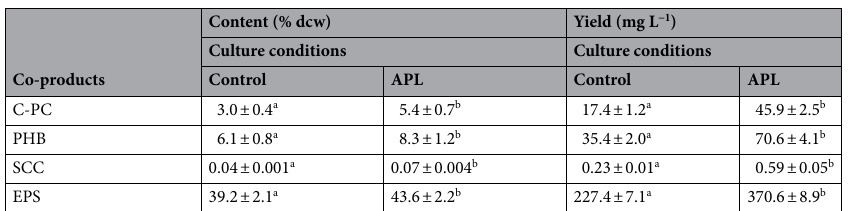
also predominated by higher yields of fermentable components such as reducing sugar and glycogen (Supple- mentary Figure S1). Consequently, an elevated volumetric production of bioethanol was obtained using the APL medium. Compared to 118.4 mg L −1 in BG-11 control, the bioethanol yield obtained from APL-grown A. variabilis showed a rise to 219.9 mg L −1 , signifying a 46.2% higher value. Nevertheless, for both the conditions (control and APL), the bioethanol conversion % was found to range between 44 and 44.3% (Table 7). APL medium also served effectively for significant accumulation of all the co-products (Table 8). Using this medium, C-PC content was increased to 5.4% dcw from 3.0% dcw in BG-11 control. On the other hand, PHB and SCC contents were respectively enhanced to 8.3% and 0.07% dcw in the APL medium compared to 6.1% and 0.04% dcw in control. A marginal increase was also witnessed in the EPS content from 39.2% (control) to 43.6% dcw (APL medium). This upsurge in the cellular concentration of the co-products alongside the augmented biomass yield of A. variabilis in the APL medium also heightened their volumetric production. A ~ 61–62% increase was noted for SCC and C-PC yield, recording respective values of 0.59 mg L −1 and 45.9 mg L −1 in the APL medium compared to 0.23 mg L −1 and 17.4 mg L −1 in BG-11 control. Likewise, the yield of PHB and EPS were also elevated to 70.6 mg L −1 and 370.6 mg L −1 from 35.4 mg L −1 and 227.4 mg L −1 in control, indicating a respective ~ 50% and ~ 39% rise (Table 8). Bioethanol and the co-products harnessed from A. variabilis and their validation using different confirma- tory analyses have been summarized in Fig. 4, the comprehensive illustration of which has been provided in Supplementary Figures S2–S7. Bioethanol was obtained after fermentation of the pretreated hydrolysate and harvested by phase separation (Fig. 4a) using Tri-n-butyl phosphate (TBP). The bioethanol production was confirmed using GC–MS analysis, where its presence was detected at the retention time of 1.68 min (Fig. 4a and Supplementary Figure S2), refer- ring to the NIST mass spectral library. C-phycocyanin (C-PC) was extracted as water-soluble blue color pigment and stored as freeze-dried powder (Fig. 4b). The confirmatory detection of C-PC was based on the spectrophotometric determination of the distinct peak at 620 nm, the absorption maxima of C-PC (Fig. 4b and Supplementary Figure S3). Poly-β-hydroxybutyrate (PHB) was extracted as white polymer, and its accumulation in A. variabilis was detected using GC analysis (Fig. 4c). The polymer sample obtained from the test cyanobacterium conformed to the standard PHB exhibiting the specific peak at the retention time of 4.5 min, hence, confirming PHB synthesis by A. variabilis (Supplementary Figure S4). Chlorophyll extracted from A. variabilis was converted into its water-soluble derivative- sodium copper chlorophyllin (SCC), which appeared as blue-black powder (Fig. 4d). The identification of SCC was performed using two confirmatory tests (copper test and flame test) to validate the presence of copper in it. In copper test, the formation of a brown-colored complex of copper diethyldithiocarbamate after addition of sodium diethyl- dithiocarbamate confirmed the presence of copper in the produced SCC sample. In flame test, the SSC sample solution burnt with a green-colored flame, hence, reconfirming the presence of copper in it (Fig. 4d). Addition- ally, the absorption spectrum of the produced SCC sample was also found to be similar to the standard SCC, showing peaks at the wavelengths of 405 nm and 635 nm (Supplementary Figure S5). This analogy in absorbance behavior again validated the SCC formation in the present study. Exopolysaccharides (EPS) extracted from the test cyanobacterium when freeze-dried appeared as white cottony fiber (Fig. 4e). HPLC analysis revealed the obtained EPS to be constituted of pentoses like ribose and xylose; and hexoses, such as mannose, glucose, and galactose (Supplementary Figure S6), demonstrating the